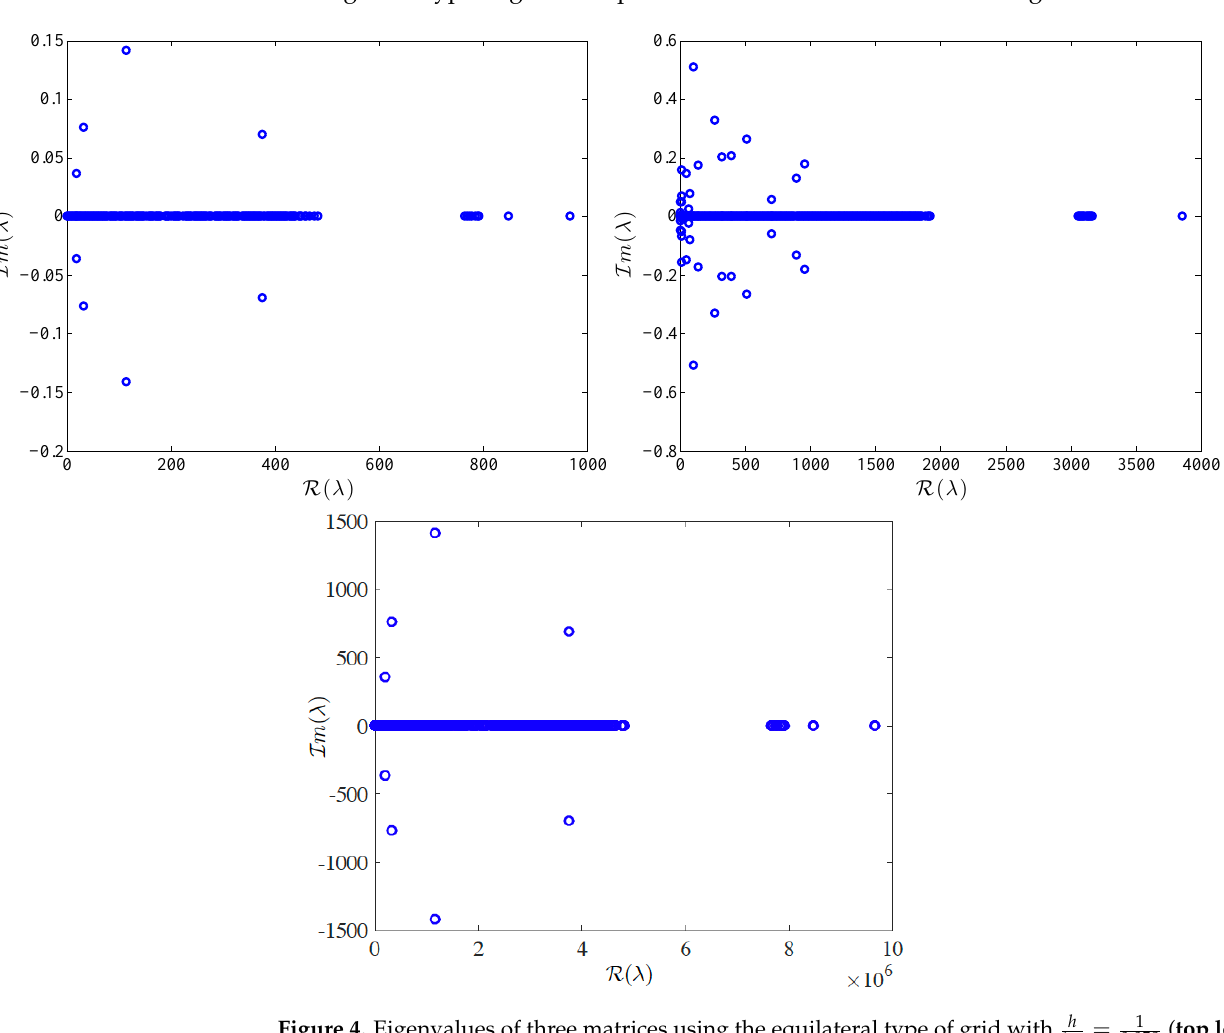
Figure 4. Eigenvalues of three matrices using the equilateral type of grid with h 1 ( top right ) and 100 0.031